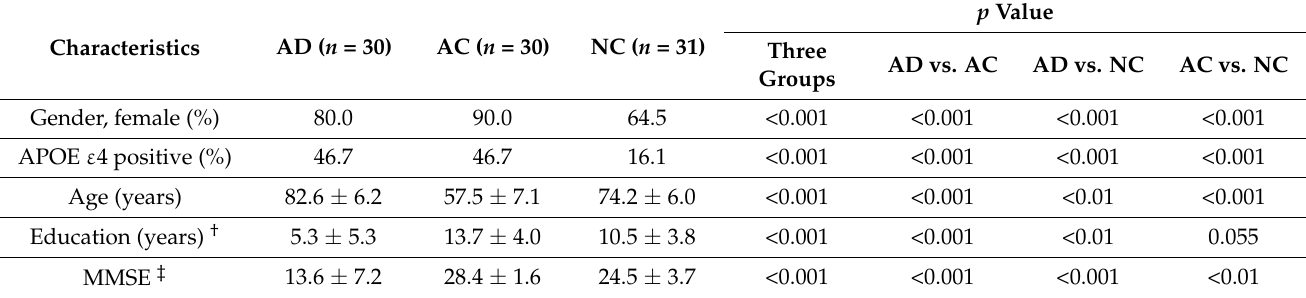
Table 1. Demographic and clinical characteristics of studied participants.